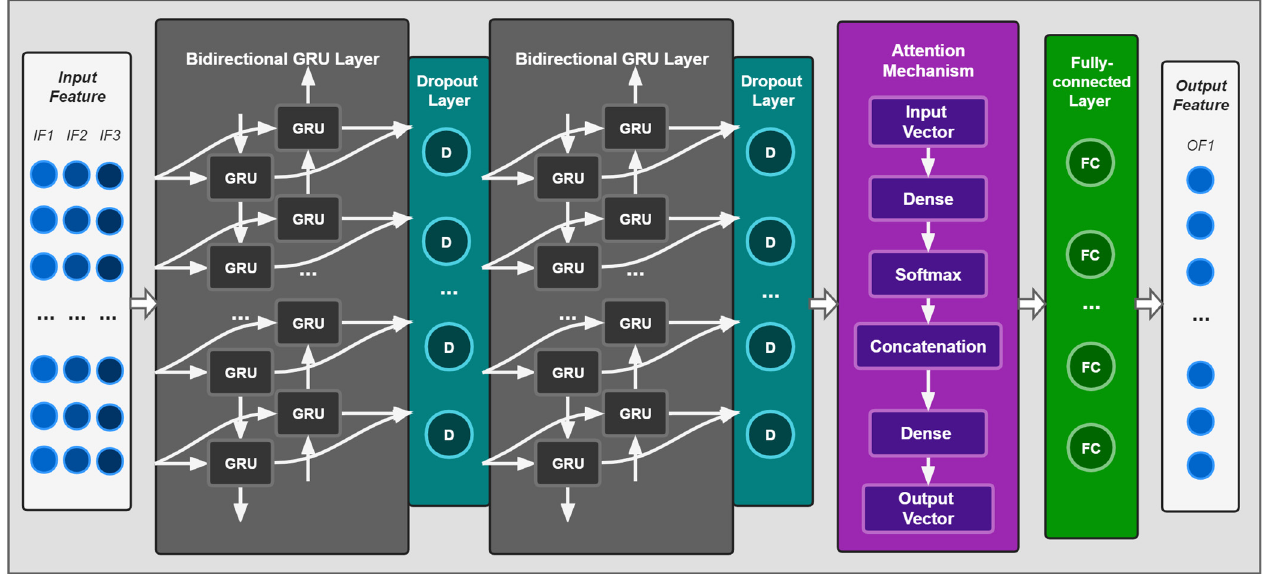
Figure 2. Structural illustration of the proposed Att-DBGRU architecture.